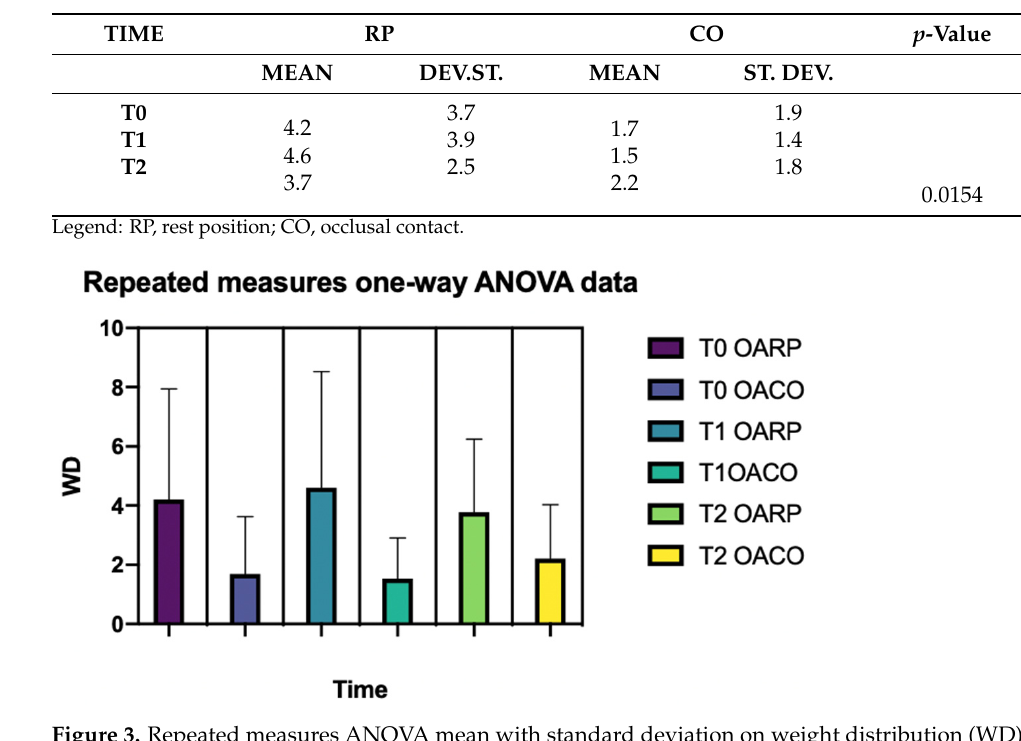
Figure 2. Repeated measures ANOVA mean with standard deviation on barycenter (Xmm). Table 2. Friedman test on weight distribution (WD) . Table 2. Friedman test on weight distribution (WD).